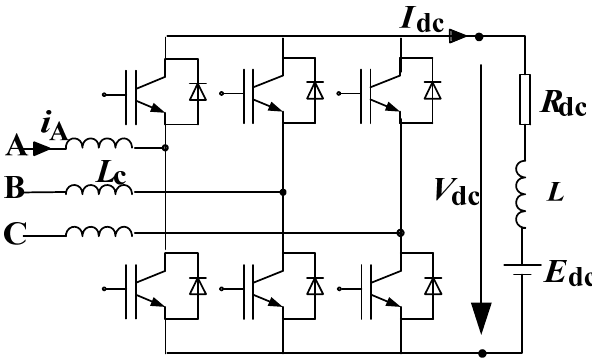
Figure 6. The circuit diagram of AC/DC converter with the equivalent